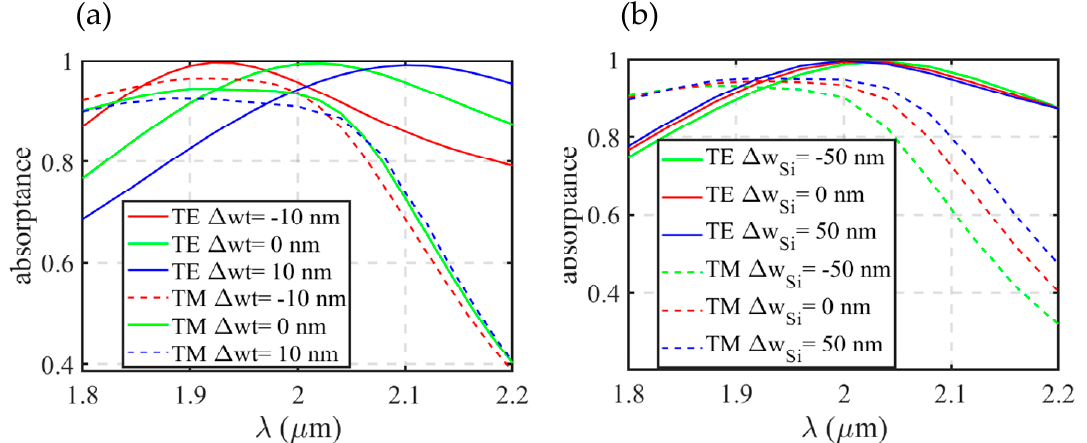
Figure 12. Absorption spectra of Au-7 nm-thick single layer structure with the offset of ( a ) metal width wt ; and ( b ) Si waveguide width w Si .